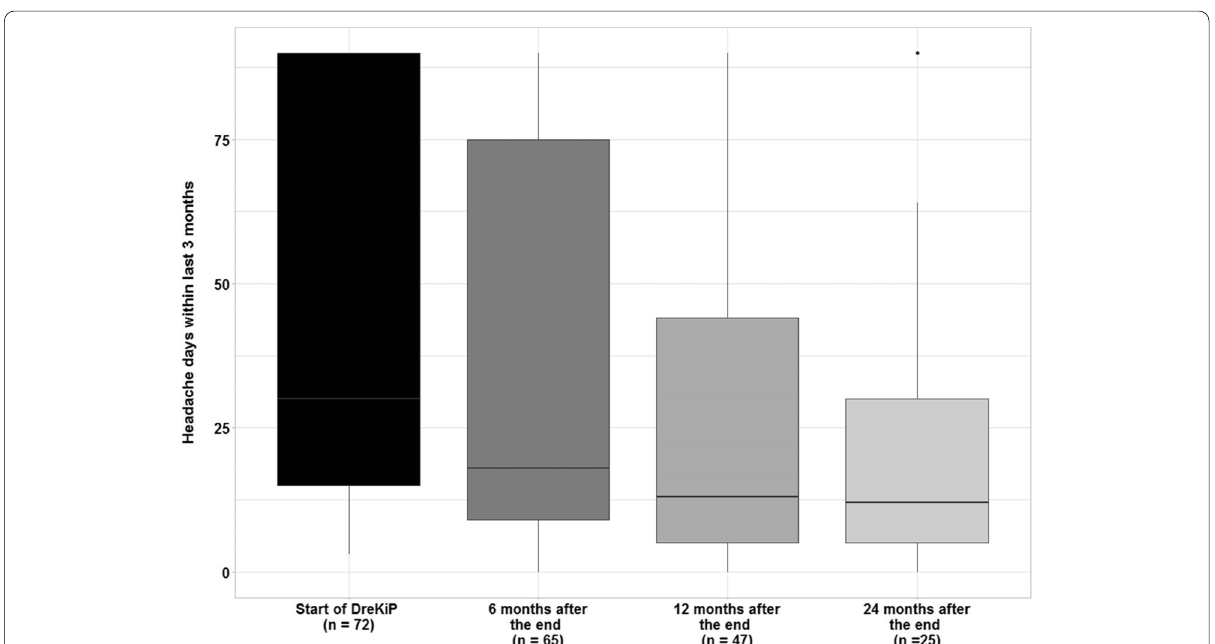
Fig. 3 Headache frequency. (Median headache days in the last 3 months) at baseline and follow up 6, 12 and 24 months after the program “DreKiP” (stands for Dresden children and adolescent headache